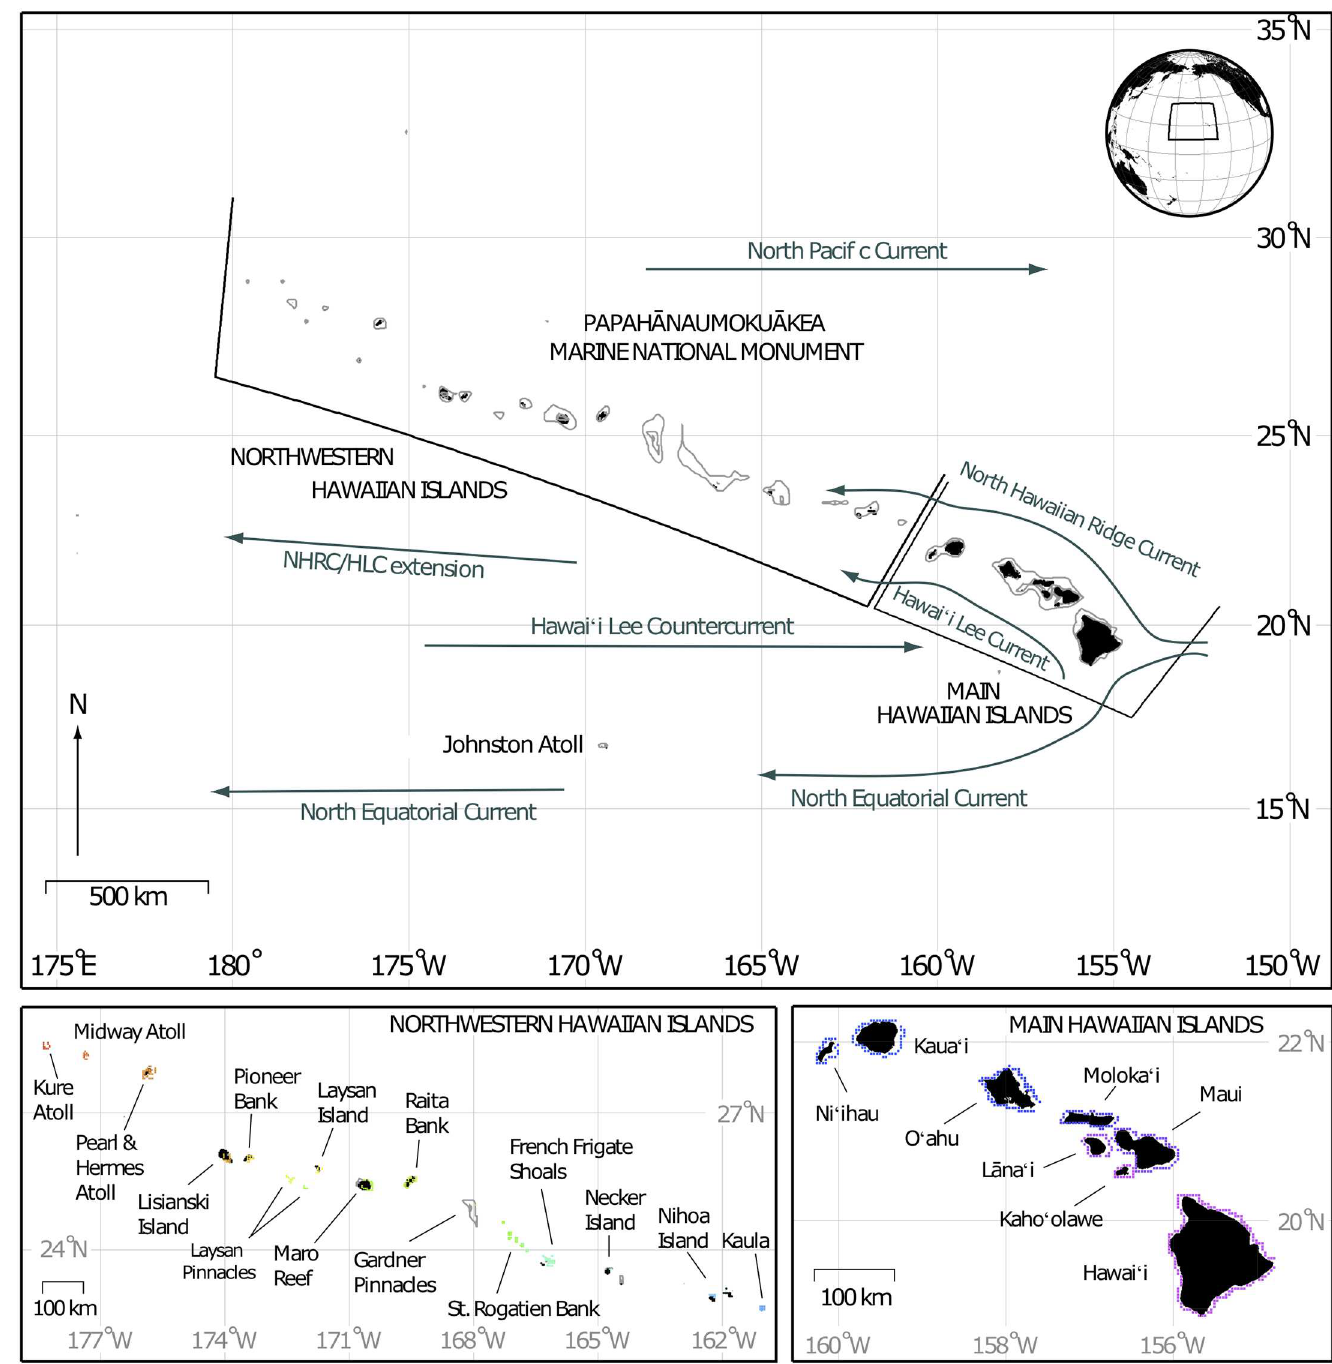
Fig 1. Map of the Hawaiian Archipelago. Top panel showingthe Hawaiian Archipelagodomain of the dispersalmodel with the major surface currents (in green) identified(after Lumpkin1998). Bathymetry lines denote 1000 and 50 m isobaths. Bottom panels show coral reef habitat pixels for the Northwestern Hawaiian Islands and Main HawaiianIslands respectively, with each island’shabitat pixels shown as a separatecolor. Bathymetry lines in NWHI denote 50m depth isobath.